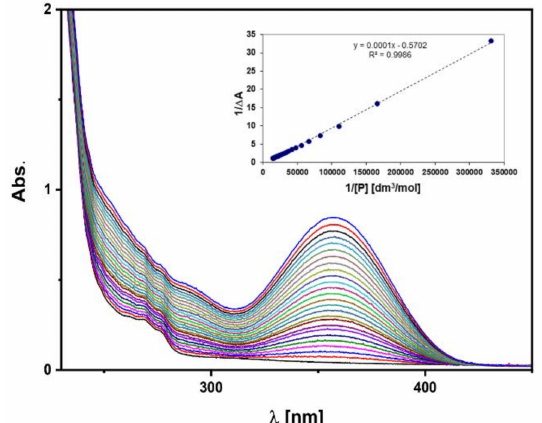
Figure 6. Absorption spectra of the C-PUL solutions in the presence of various concentrations of piroxicam (c C-PUL = 1 mg / mL; piroxicam concentration range: 0–0.07 [mM]. The insert presents 1 / ∆ A as a function of 1 / [ P ] and the linear